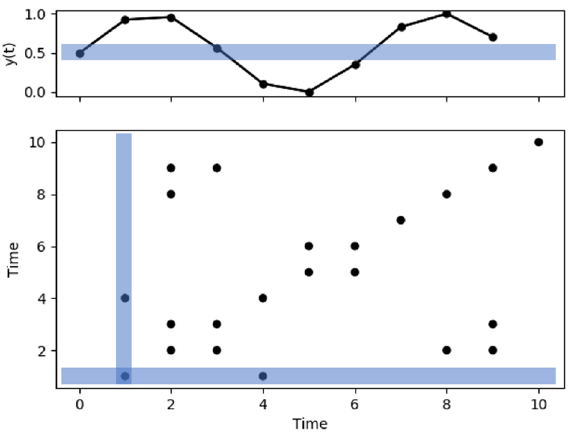
Figure 1. Schematic describing the construction of a recurrence plot. The upper panel shows the series of observations vs time. A region centered on the first data point, with width 2 ǫ is shaded in blue. The lower panel shows the corresponding recurrence plot. The elements of the recurrence plot corresponding to the first point are shaded in blue, in the lower panel. When a point falls within the blue rectangle in the upper panel, it is shown as a black point in the lower panel. This analysis is repeated for every point in the time series resulting in the complete recurrence plot. The x and y axes of the recurrence plot represent the time of observation (x axis of the upper panel). Hence, when an observation y ( t 1 ) at time t 1 and y ( t 2 ) at time t 2 are within ǫ distance of each other, the point ( t 1 , t 2 ) is marked in black in the recurrence